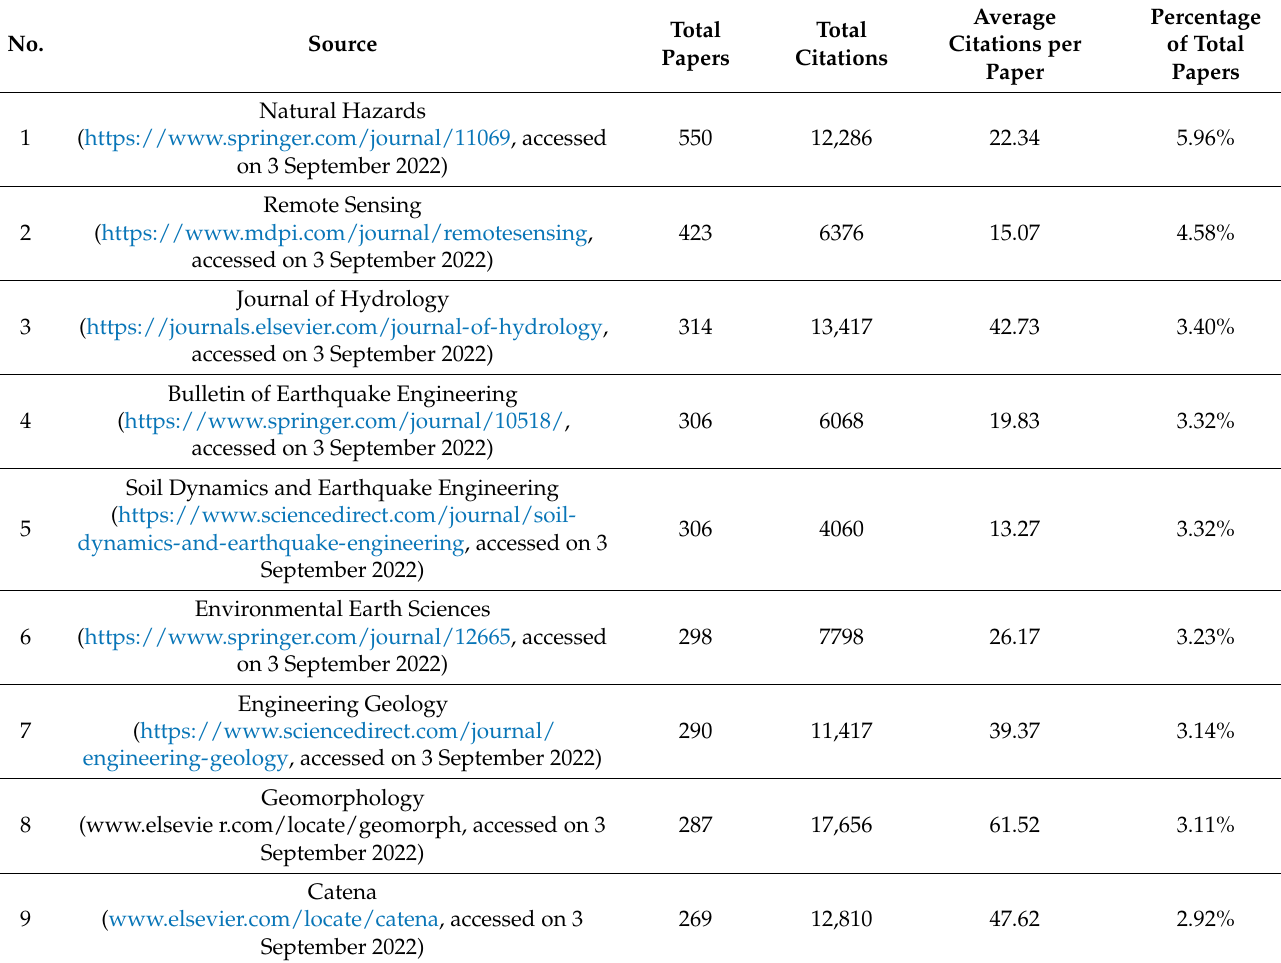
Table 1. Top 15 source journals according to the number of publications in AI for geohazard research